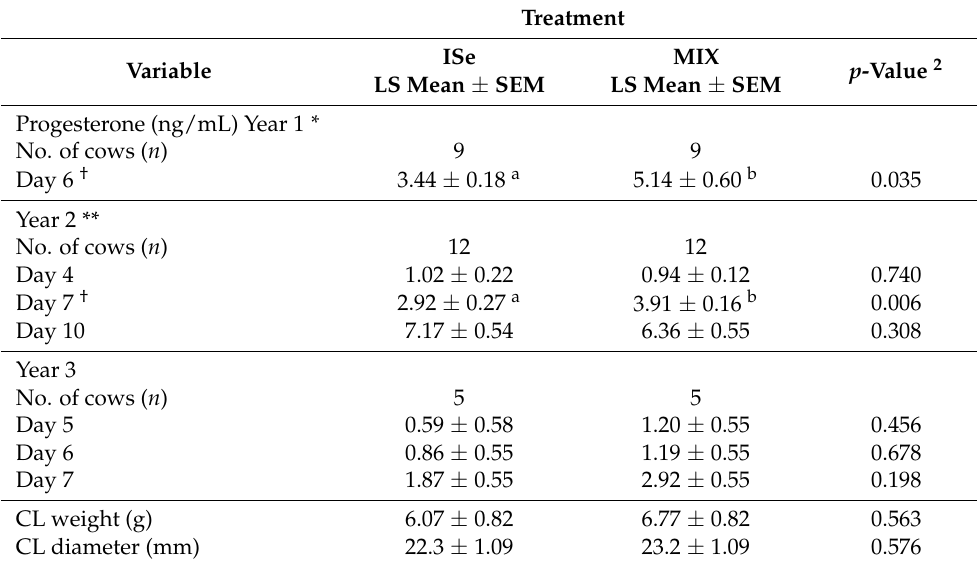
Table 2. Effect of treatment (form of supplemental Se) on the concentration of systemic P4 in cows between days 4 and 10 of the estrous cycle. Cows were supplemented with Se as sodium selenite (ISe, n = 5) or a 1:1 equimolar mix of ISe and OSe (MIX, SEL-PLEX, n = 5) 1,† .